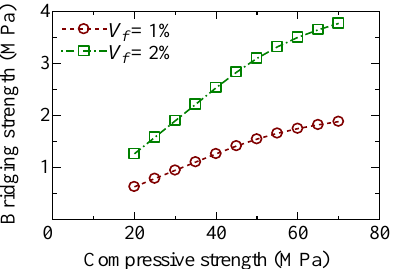
Figure 16. Effect of matrix compressive strength on bridging strength of fiber.